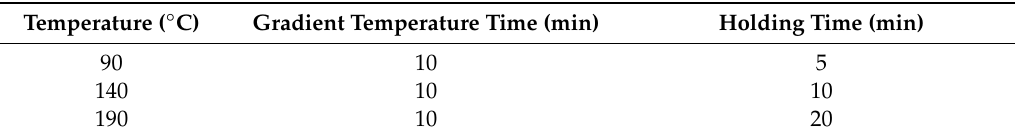
Table 2. Microwave-assisted digestion procedure.